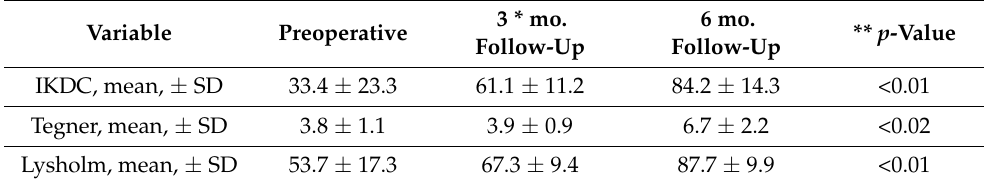
Table 3. Outcomes before and at each